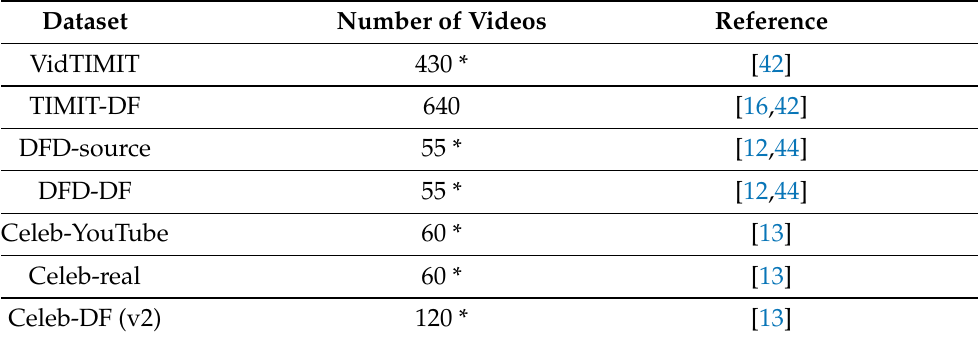
Table 5. Collection of datasets used for this